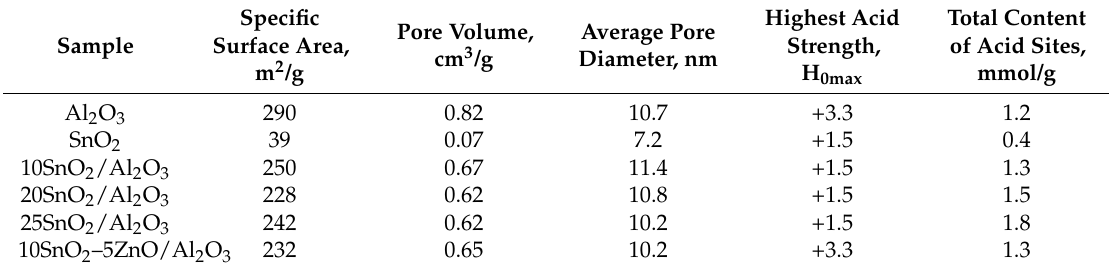
Table 1. Textural parameters and total acidity of synthesized SnO 2 /Al 2 O 3 samples.